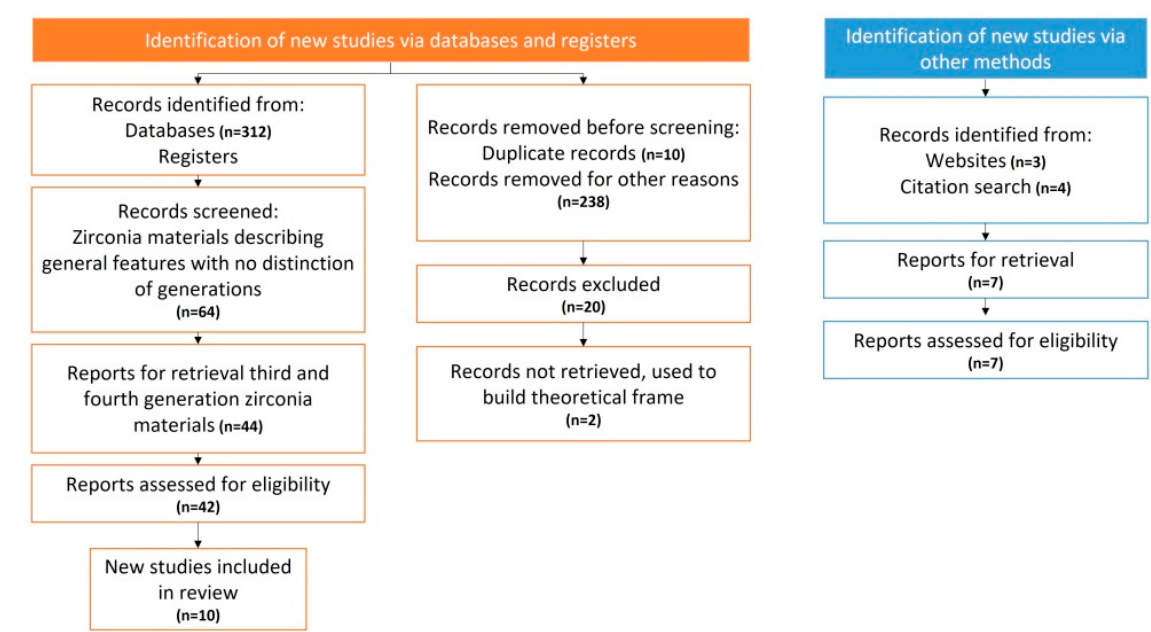
Figure 1. Flow chart of the literature search.